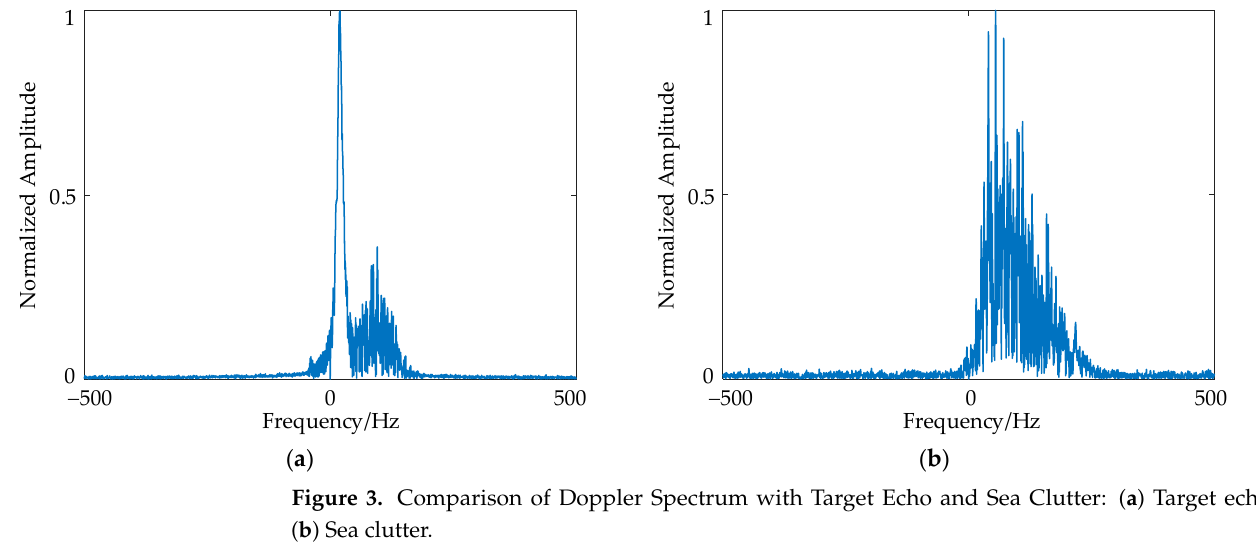
Figure 3. Comparison of Doppler Spectrum with Target Echo and Sea Clutter: ( a ) Target echo; ( b ) Sea clutter.